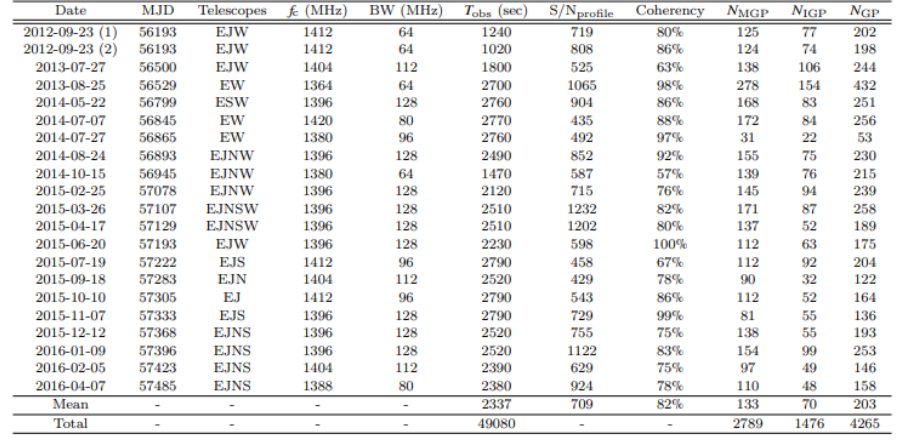
Table 1. Summary of the LEAP observation of PSR B1937+21.